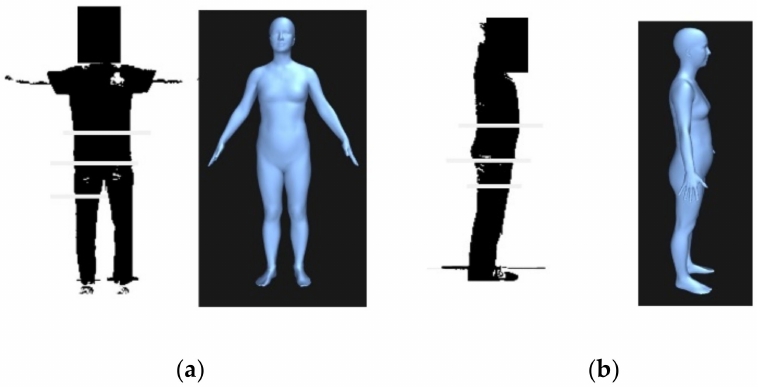
Figure 11. 3D reconstruction from two 2D images of the user. ( a ) Frontal view. ( b ) Lateral